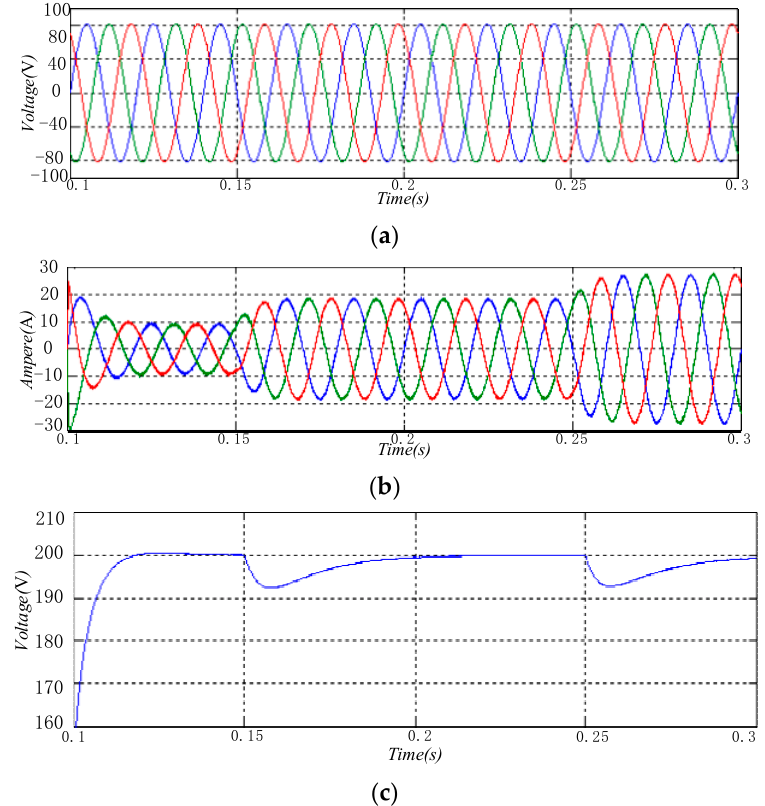
Figure 13. Simulation diagram of three-phase balanced PWM rectifier. ( a ) Steady waveform of Three-phase voltage; ( b ) Steady waveform of Three-phase current; ( c ) DC dynamic capacitance voltage waveform.